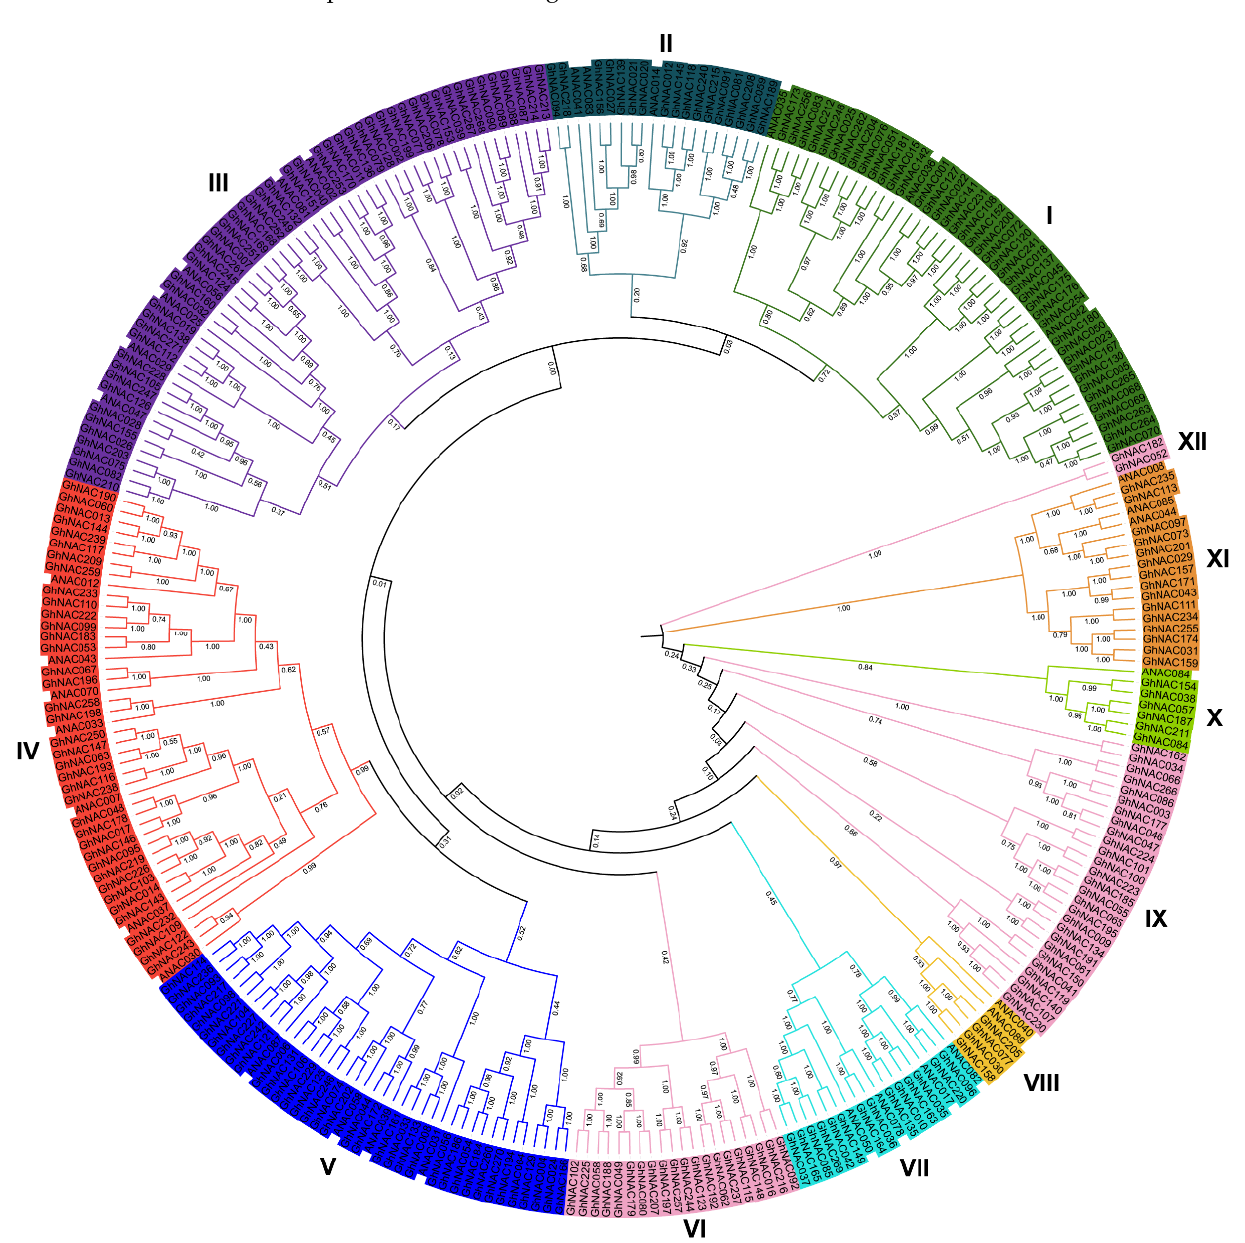
Figure 1. Phylogenetic tree of the 271 GhNAC proteins. Multiple sequence alignment of NAC domain sequences of G. hirsutum L. and Arabidopsis was performed using Clustal X2. MEGA 7.0 was used to construct the neighbor-joining (NJ) tree with 1000 bootstrap replicates. Various colors indicate different groups of